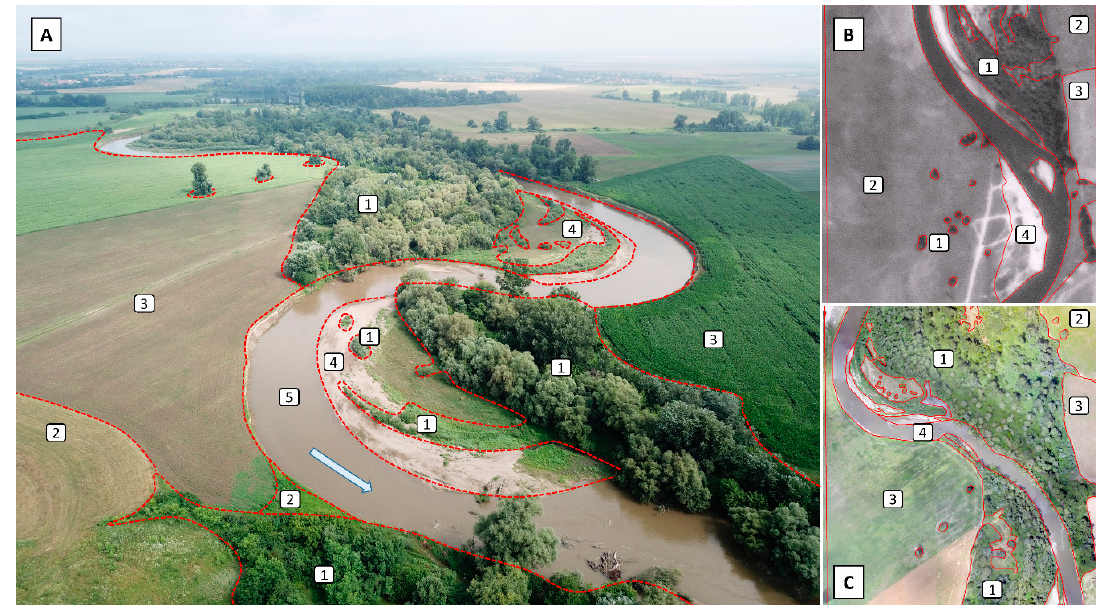
Figure 3. Aerial overview of the study area with the different land use categories (1—forests and bushes; 2—grasslands; 3—arable lands; 4—bar surfaces; 5—river channel). ( A ) Oblique aerial photo by L.B., 11 June 2017; ( B ) Black & White archive aerial photo from 1975; ( C ) UAV-based orthophoto from 2017.